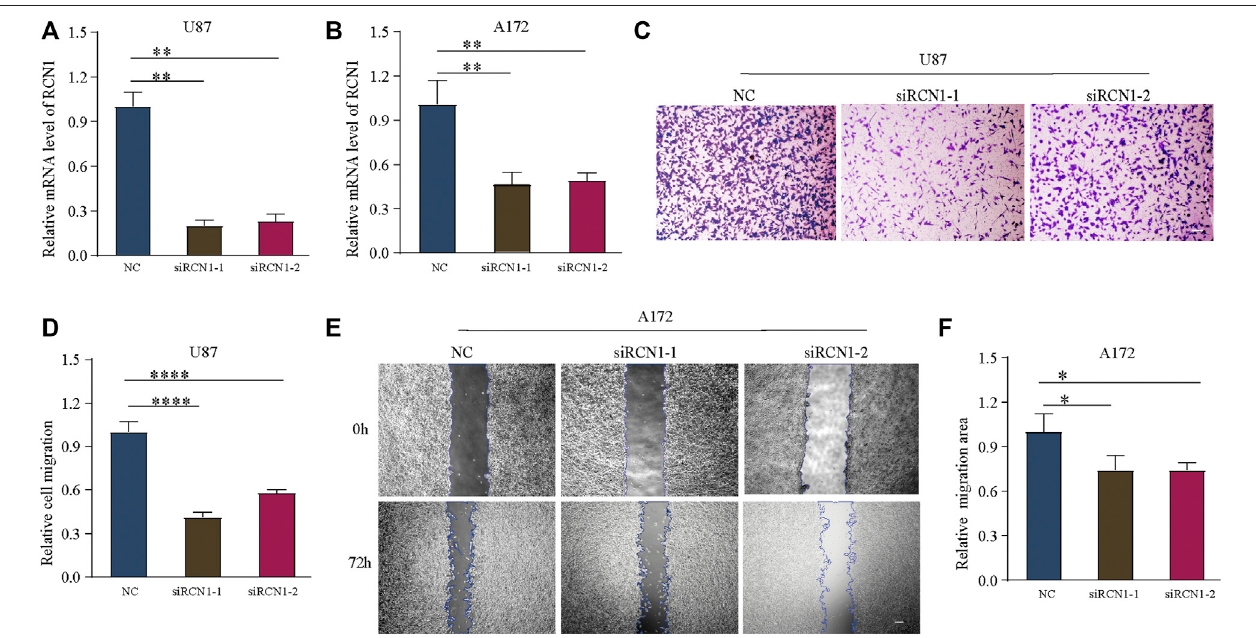
FIGURE 9 | Down-expression of RCN1 inhibits cell migration. (A,B) The mRNA of RCN1 knockdown on U87 and A172 cells after transfection. (C,D) Transwell assay. (E,F) Would healing